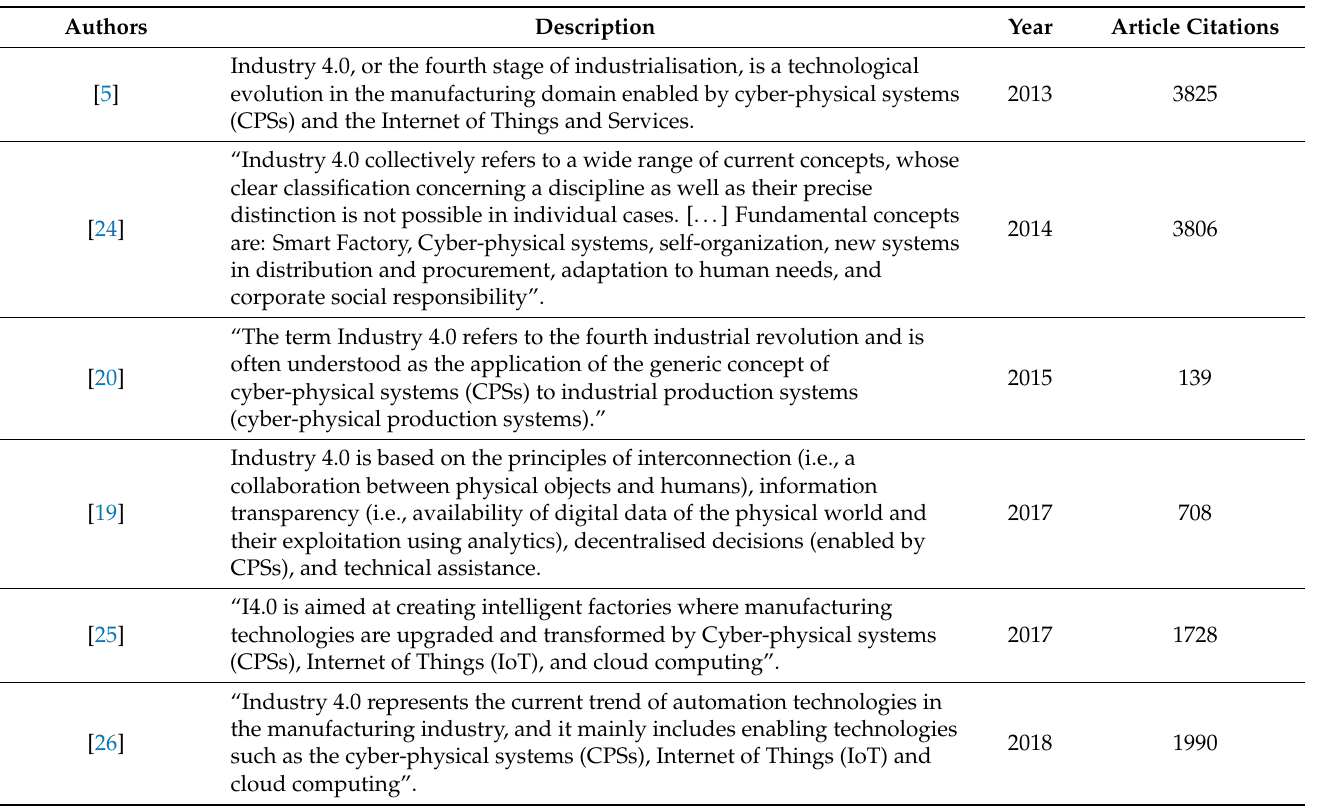
Table 1. A summary of relevant